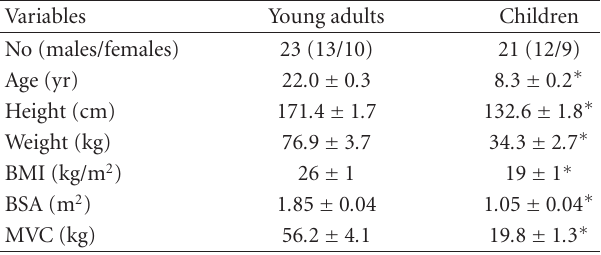
Table 1: Subject